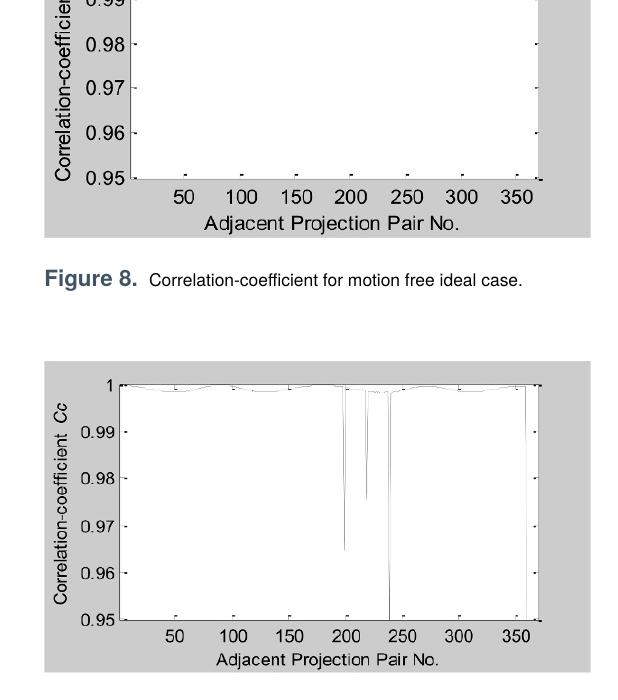
Figure 9. Correlation-coefficient for Translational motion case.